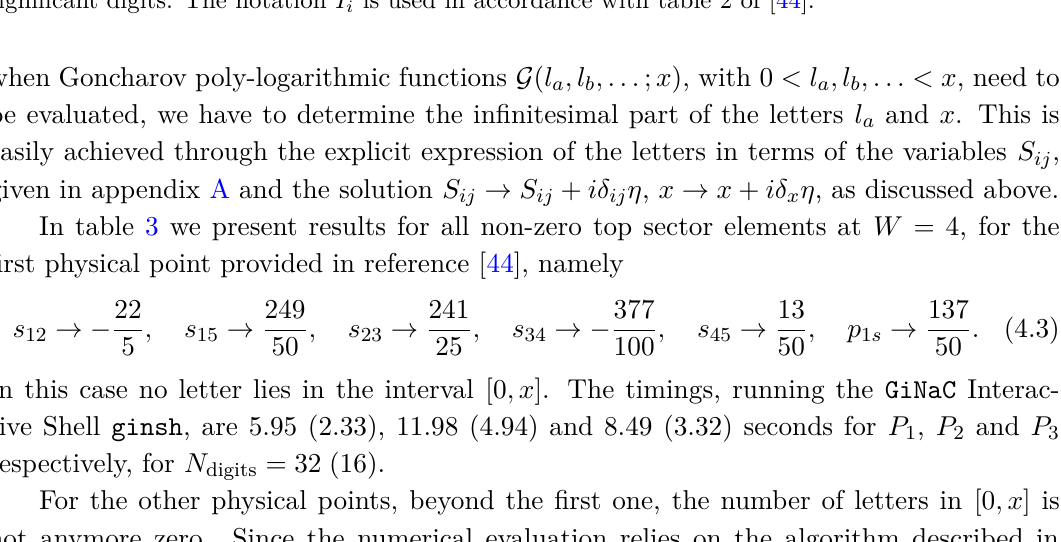
Table 3 . Numerical results for the non-zero top sector element of each family at weight 4 with 32 significant digits. The notation I i is used in accordance with table 2 of